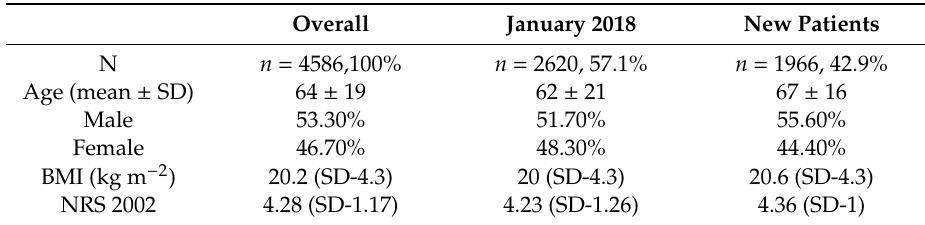
Table 1. Basic demographic